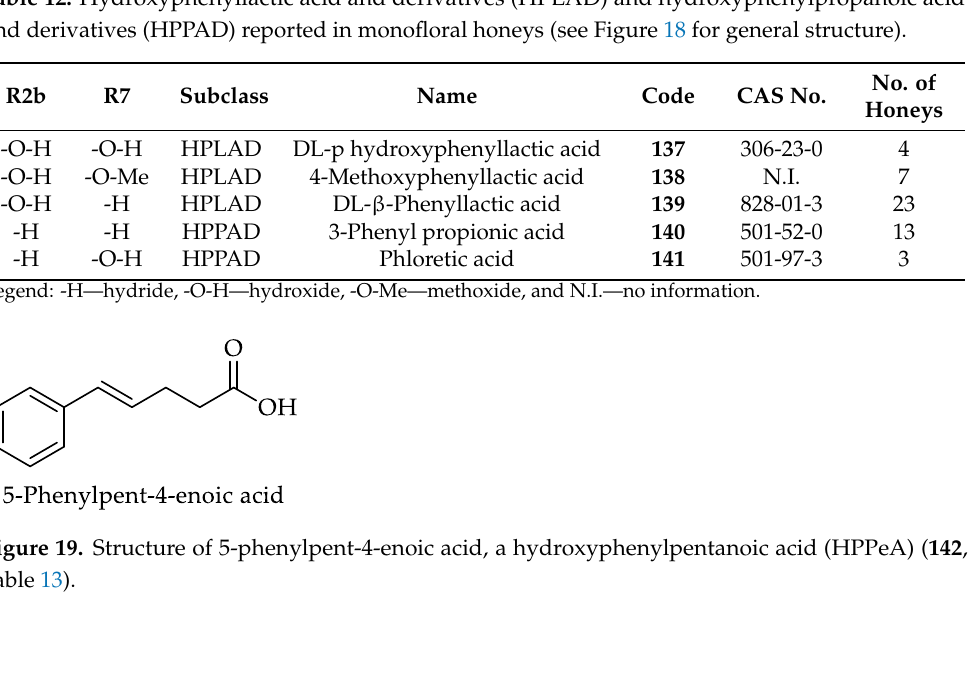
Figure 20. Basic structure of other phenolic compounds (see 143 – 156 in Table 14). Table 14. Alkylmethoxyphenol, alkylphenols, hydroxybenzaldehydes, hydroxybenzoketones and hydroxyphenylketone reported in monofloral honeys (see Figure 20 for general structure). R1